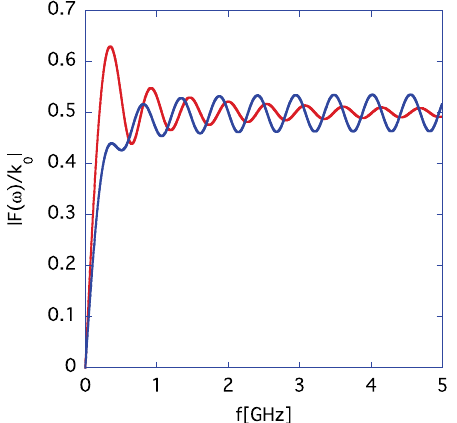
FIG. 5. The transfer function of the triangle electrode (red) and the one for the exponential electrode (blue).